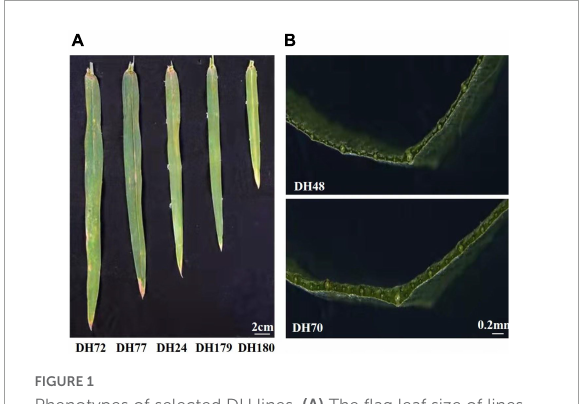
FIGURE1 Phenotypes of selected DH lines. (A) The flag leaf size of lines from the Jinchun 7 × Jinmai 919 DH population. (B) Lines with different flag leaf thickness from the Jinchun 7 × Jinmai 919 DH